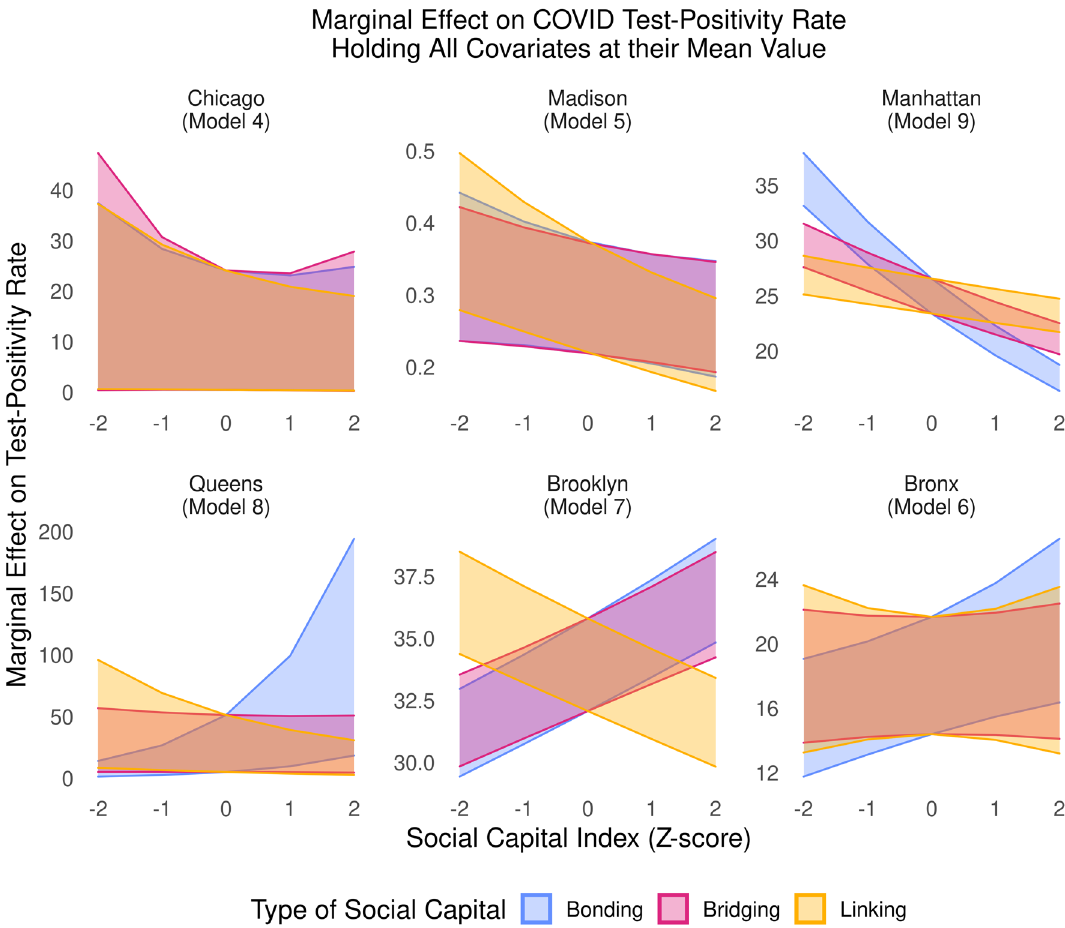
Figure 4. Marginal effects of social capital on COVID-test positivity rates. Bands depict marginal effect on test positivity rates as specified type of social capital varies by 2 standard deviations around the mean, holding all other variables at means and modes. Bands reveal varied effect of social capital subtypes depending on